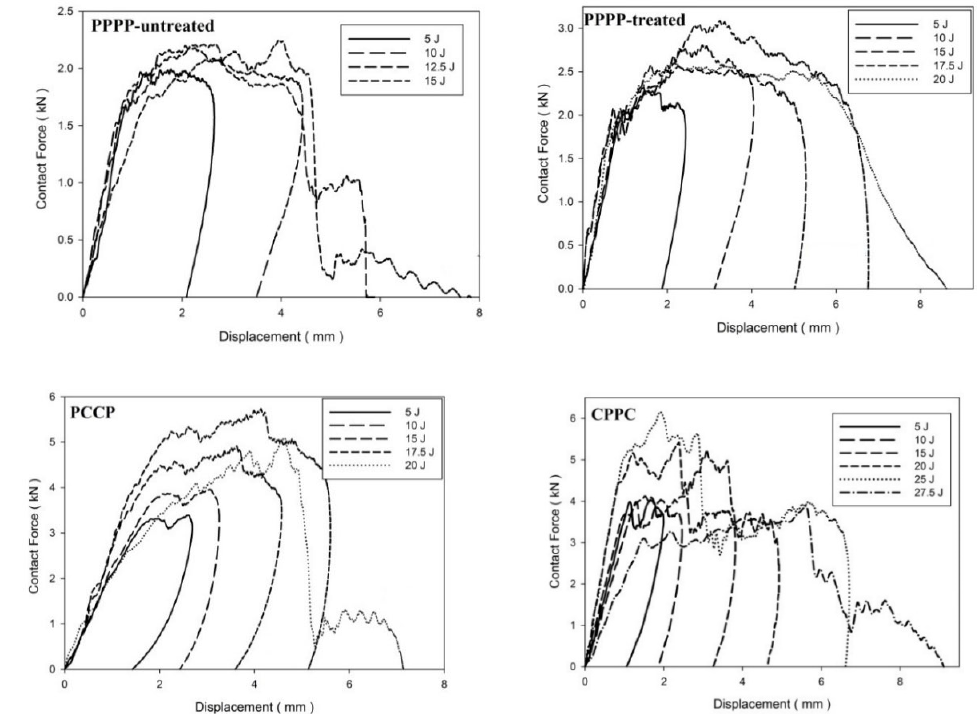
Figure 9. Contact force–displacement of the hybrid laminates at ply orientations of [ ± 45 ◦ 2 , 0 ◦ /90 ◦ 2 ] s .